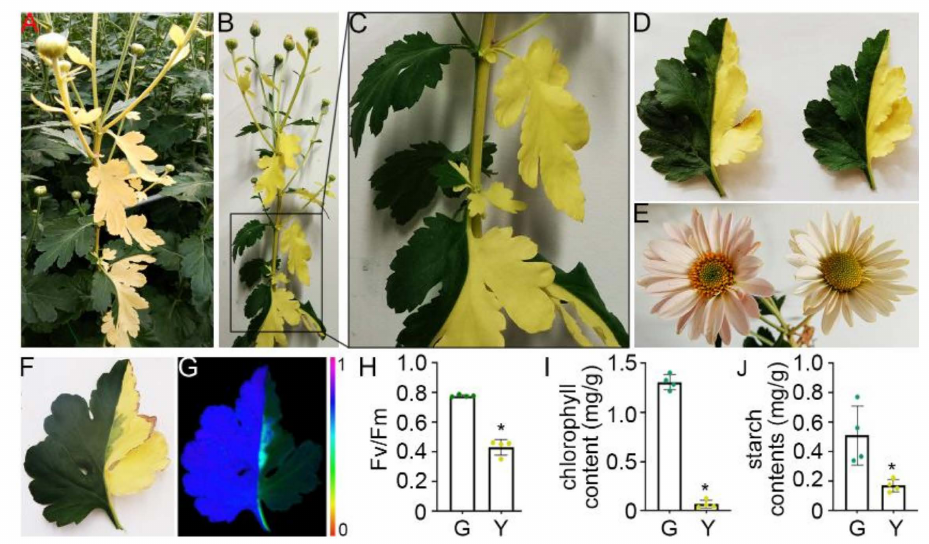
Figure 1. Phenotypic characterization of chrysanthemum bud sport mutant. ( A ) The bud sport mutant plant with yellow branches in the field-grown chrysanthemum variety ‘Nannong Binyun’; ( B ) The bud sport mutant plant shows an asymmetrical half-green and half-yellow appearance in the main stem and branches; ( C ) an enlarged view of the boxed region in ( B ); ( D ) the phenotype of leaves with half-green and half-yellow appearance; ( E ) the phenotype of flowers generated from green (left) and yellow (right) branches in the same plant; ( F ) a bud sport mutant leaf used for Fv/Fm measurement; ( G ) images of chlorophyll fluorescence parameters Fv/Fm of the bud sport mutant leaf. The color code depicted at the bottom of the image ranges from 0 (red) to (1) purple; ( H ) the photochemical activity of Fv/Fm of four biological replicates; ( I ) chlorophyll content in the green and yellow tissues based on three biological replicates, and ( J ) starch content of the green and yellow tissues based on three biological replicates. * p < 0.05 when compared to the control by one-tailed unpaired t -test. Error bars represent SD. G indicates green tissues, Y indicates yellow